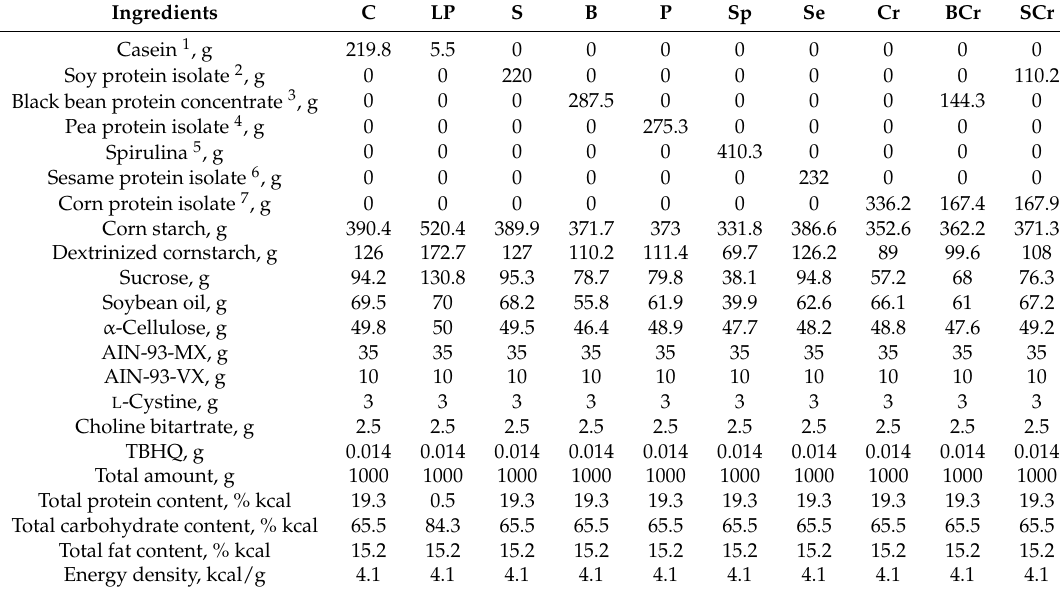
Table 1. Composition of experimental diets used in healthy and protein restricted